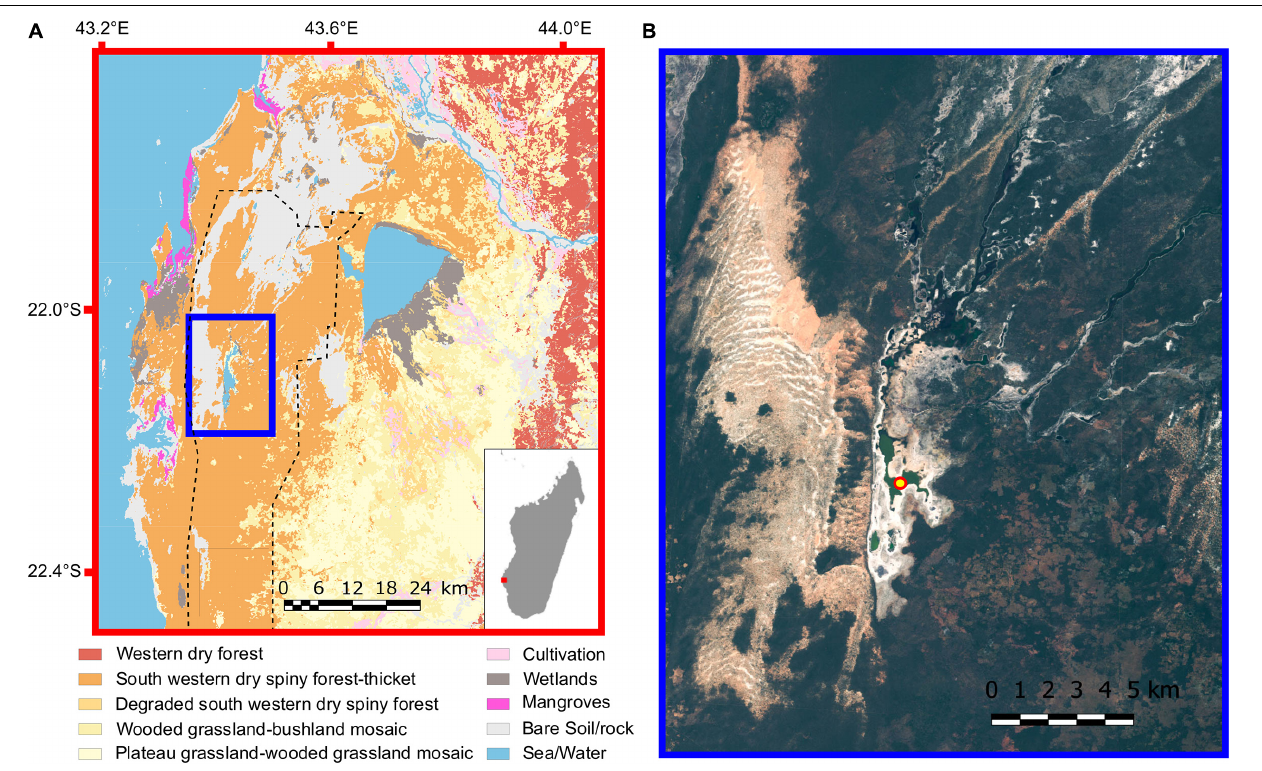
FIGURE 1 | (A) Vegetation map showing the Namonte Basin, circumscribed by the blue rectangle. Inset shows the island of Madagascar, with the red dot in the southwest indicating the study area location. The vegetation map was modified from the Madagascar Vegetation Mapping Project (www.vegmad.org). Extent of the Mikea National Park is marked with a dashed line and includes primarily dry forest (orange). (B) Sentinel 2 satellite image of the outlined blue area in (A) , showing the region of Namonte, SW Madagascar. The coring site is marked with a red and yellow circle in a portion of the Namonte Basin known as